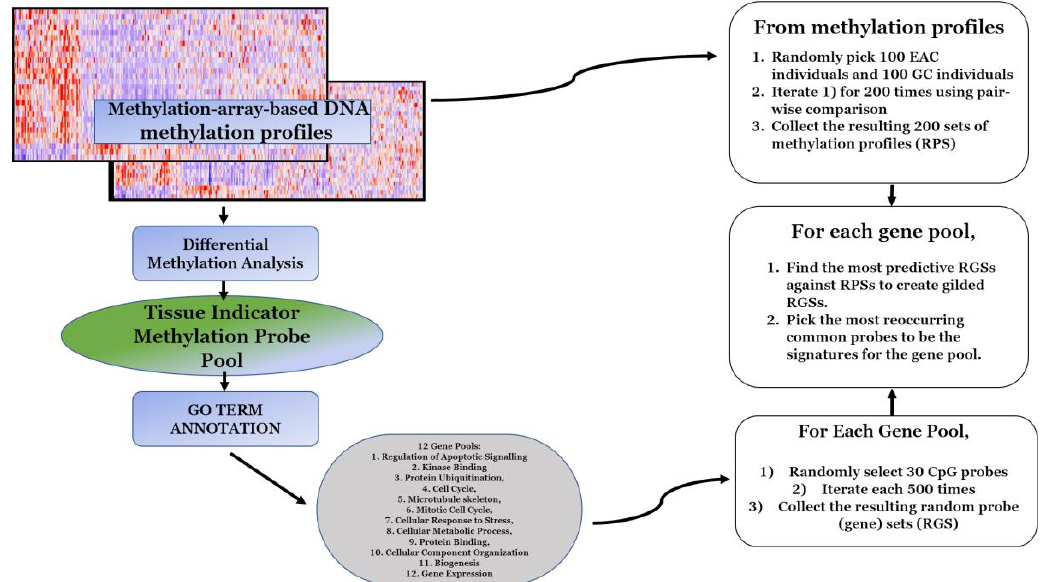
Figure 1. Diagram depicting the workflow used within the methodology. For greater detail in each step, refer to methods for dataset and further information.